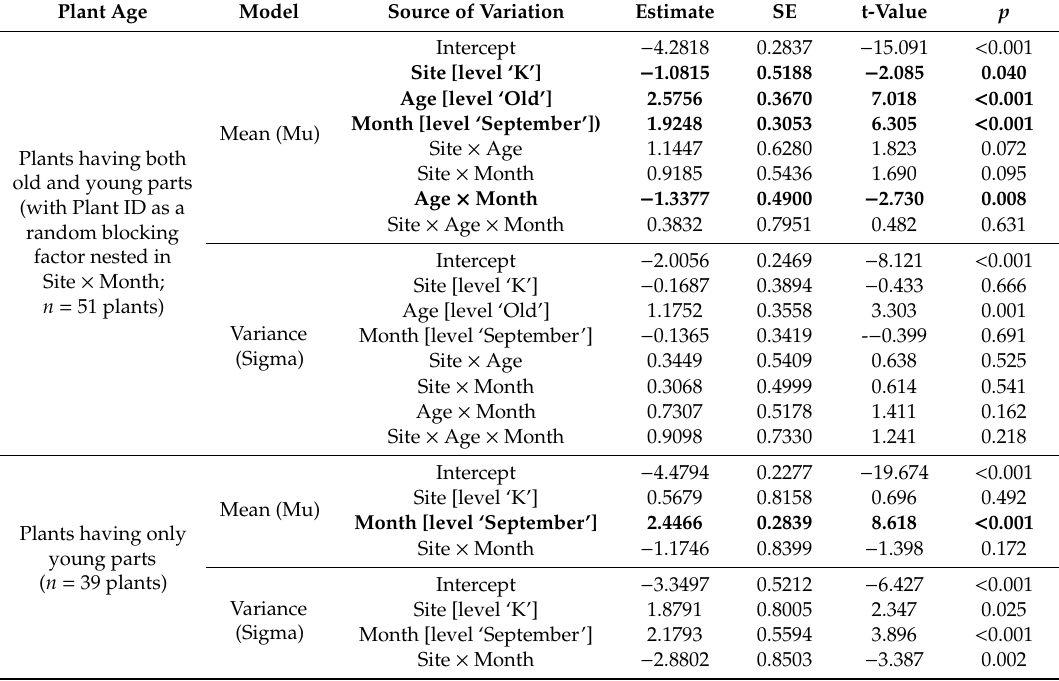
Table 1. E ff ects of plant part age (fixed, young or old), month (fixed, July or September), and location (fixed, sites K or V) on total cover of Phycodrys rubens epibiosis in 2015: beta-regression, mean (logit link) and variance (log link) modeled, frames pooled. Auxiliary non-randomly sampled (in September only) five largest plants per frame not included (see Materials and Methods). Significant terms in a mean model highlighted in bold.